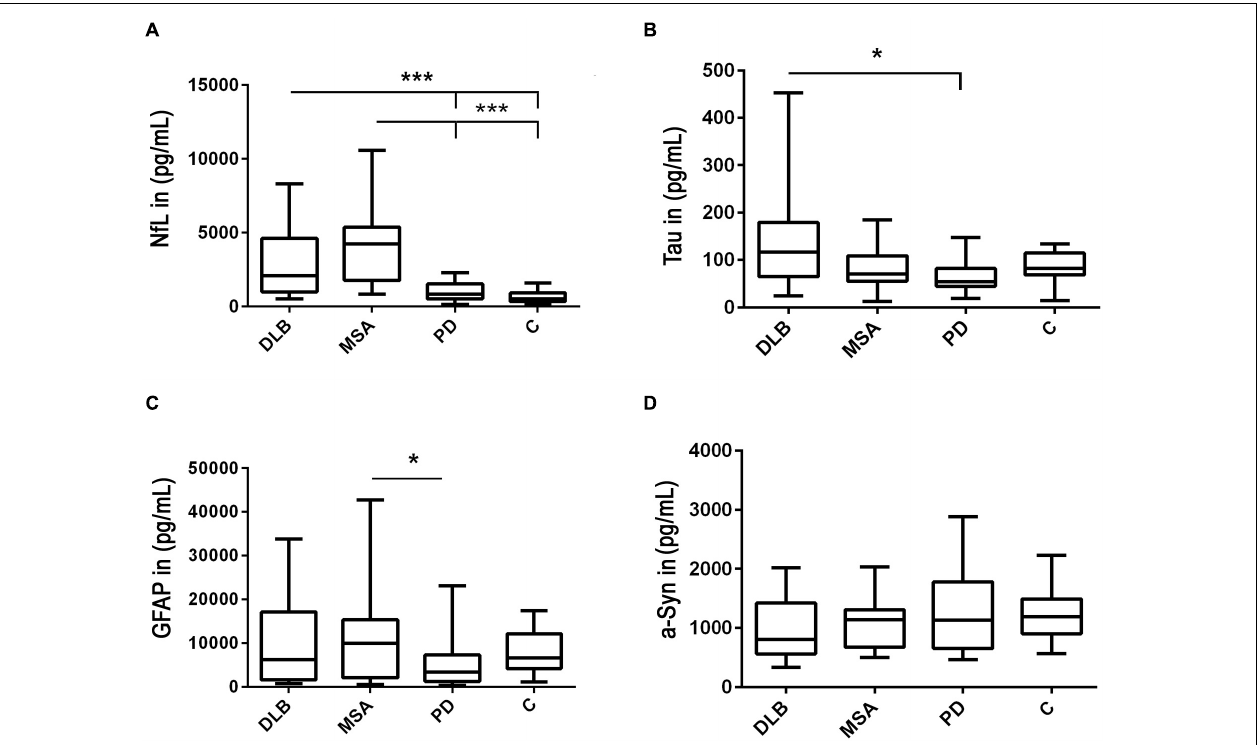
FIGURE 1 | Detection of neurofilament light chain (NfL), glial fibrillary acidic protein (GFAP), alpha-synuclein (a-Syn), and tau levels in cerebrospinal fluid (CSF). Potential marker candidate proteins were determined in CSF of synucleinopathy patients with Parkinson’s disease (PD), dementia with Lewy bodies (DLB), multiple system atrophy (MSA), and controls (C). (A) The NfL levels were increased in patients with both MSA and DLB compared with PD and controls. (B) The tau levels were higher in patients with DLB than those with PD. (C) The GFAP levels were higher in patients with MSA than those with PD. (D) No significant changes in a-Syn concentrations were observed between groups. The values displayed are means and SDs. A *** p -value < 0.001 is considered as extremely significant, * p < 0.05 as significant, and p ≥ 0.05 as not significant.